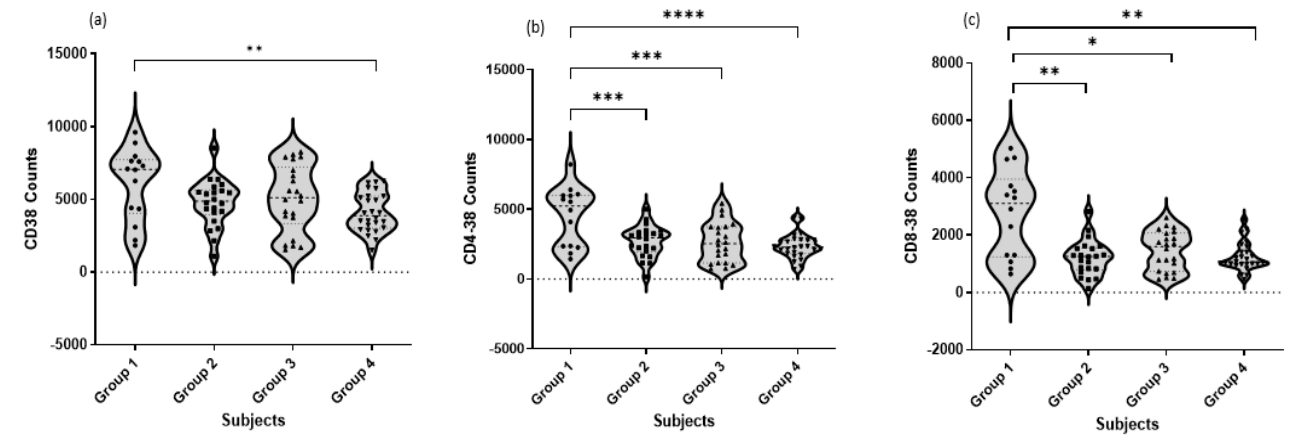
Figure 3. Comparison of cell counts of total CD38 + ( t -test) and different T cell subtypes, Th CD4 + ( t -test) and Tc CD8 + cells (Mann–Whitney), in different COVID-19 patients. Data represent cell counts of ( a ) CD38 + , ( b ) CD4 + CD38 + , and ( c ) CD8 + CD38 + T cells in mild/asymptomatic, moderate, and severe/critical COVID-19 patients. For all analyzed T cell subtypes, a significant difference was recorded between healthy control and COVID-19 groups of patients. * p -value < 0.05 is considered significant, ** p -value < 0.01 is considered very significant, *** p -value < 0.001 and **** p -value < 0.0001 are considered extremely significant.